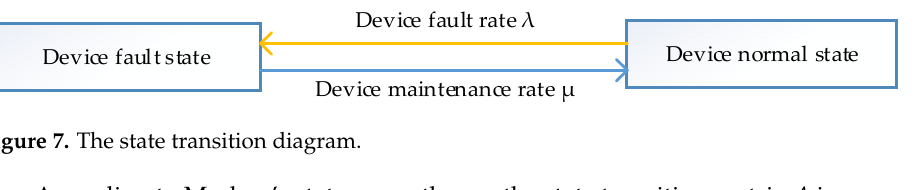
Figure 6. ( a ) Doing Algorithm 1 for RBP_L2_B3; ( b ) mapping and iterative calculations of B1.